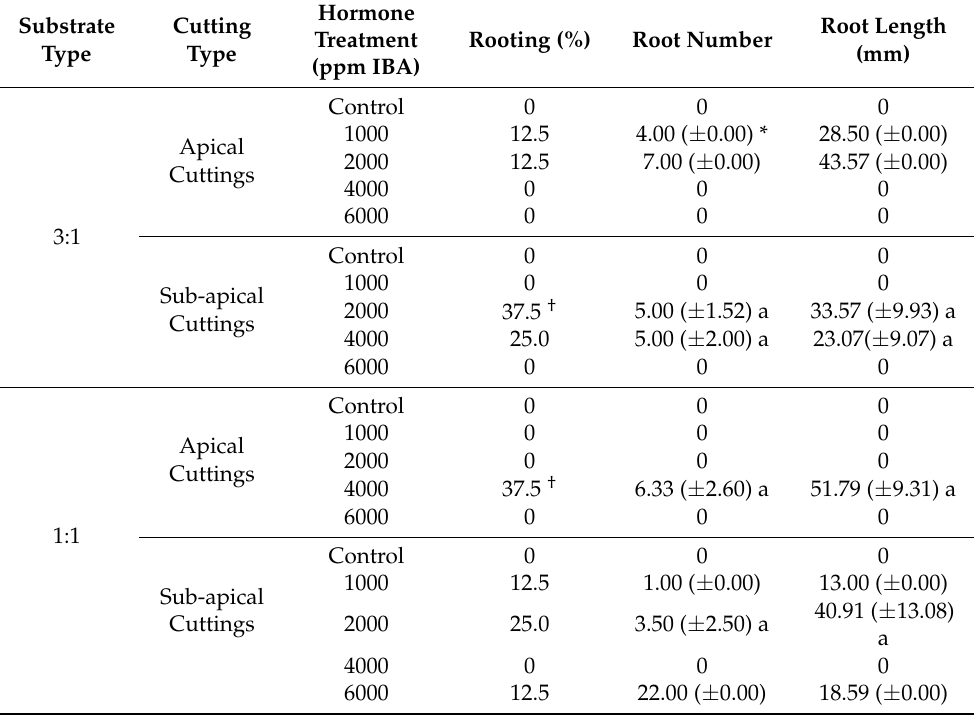
Table 4. Rooting attributes of the prioritized Rosa canina genotype GR-1-BBGK-19,191 expressed as rooting percentage (%) and mean values ( ± SEM, p < 0.05) of root number and average root length (mm) of rooted cuttings for each hormone treatment (ppm IBA) and substrate type (rooting experiment of summer 2019). All cuttings were soft-wood, leafy sections of the first growth year. The two substrate type ratios shown refer to perlite/peat ( v/v ) under mist conditions. Values within each column that do not share the same letter are significantly different (Tukey HSD, p < 0.05). Original data are included in Table